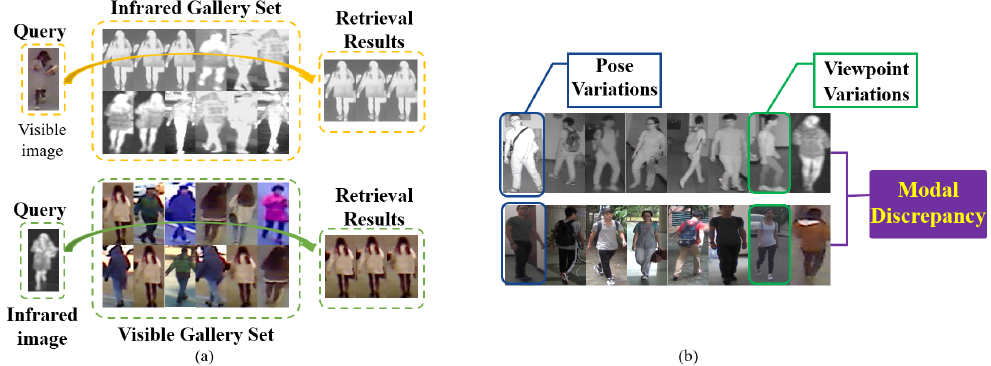
Figure 1. ( a ) The schematic diagram of visible-infrared person re-identification (VIPR) and ( b ) adverse factors in